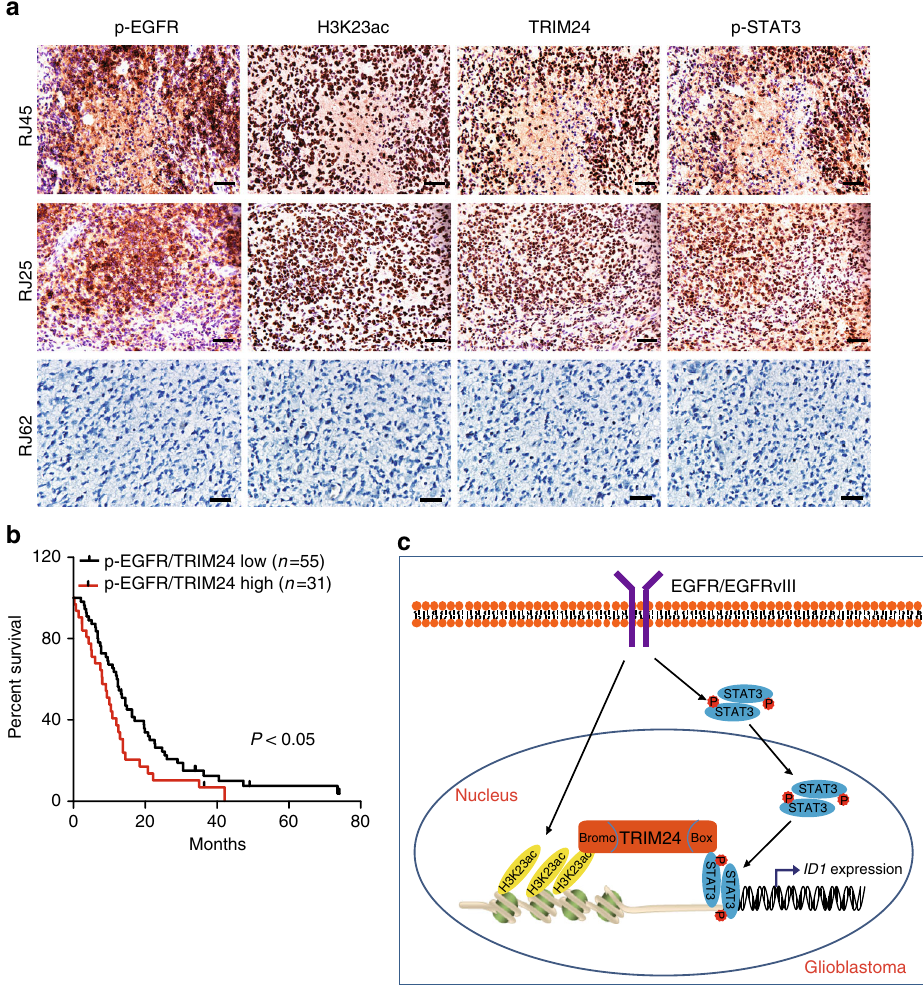
Fig. 9 Co-expression of p-EGFR, H3K23ac, TRIM24, and p-STAT3 correlates with worse prognosis of GBM. a A total of 125 clinical GBM specimens were analyzed by IHC. Representative images of serial sections of a GBM tissue using anti-p-EGFR, anti-H3K23ac, anti-TRIM24, and anti-p-STAT3 antibodies are shown. Data are representative of two independent experiments. Scale bars: 25 μ m. b Kaplan – Meier analyses of patients with high p-EGFR/TRIM24- expressing tumors (red line) vs. low p-EGFR/TRIM24-expressing tumors (black line) in IHC analyses. Median survival (in months): low, 14.5; high, 10.0. P values were calculated by log-rank test. Black bars indicate censored data. c A working model of EGFR/H3K23ac/TRIM24/STAT3 signaling pathway in glioma tumorigenesis. EGFR-upregulated H3K23ac binds TRIM24 which recruits STAT3, leading to activation of STAT3 signaling, enhancing EGFR-driven GBM